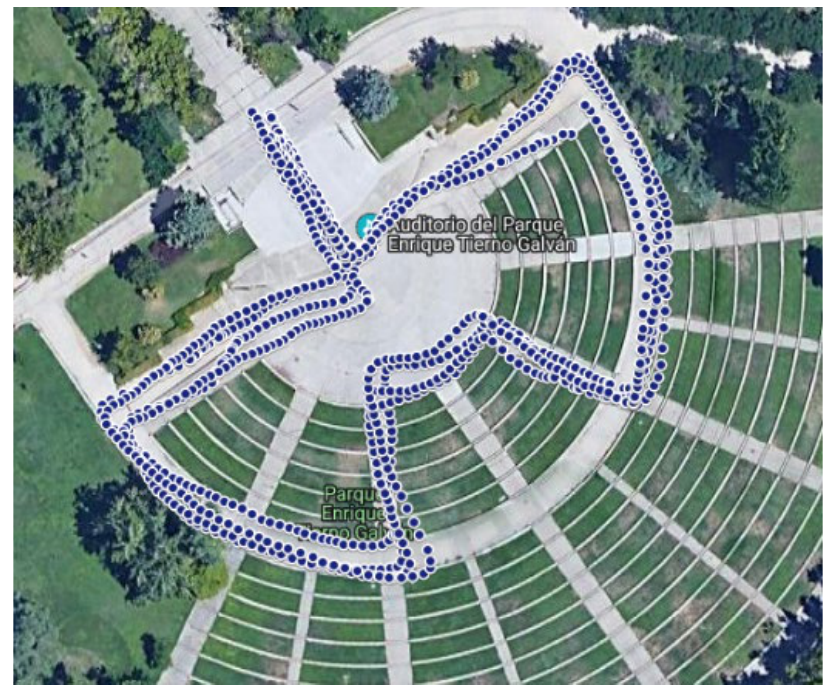
Figure 1. GPS traces along the path walked in the auditorium. (Image taken from Google Maps).